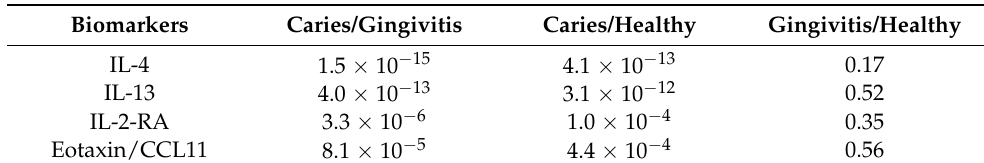
Table 1. p -values of the four biomarkers IL-4, IL-13, IL-2-RA, and eotaxin/CCL11 when comparing patients with caries, patients with gingivitis, and healthy individuals.